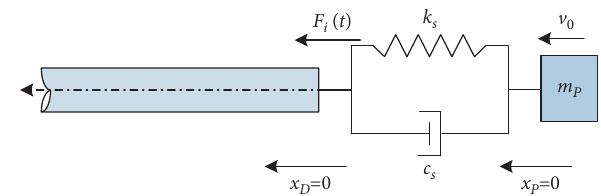
Figure 3: The mechanics simplified model of the hammer impact drill